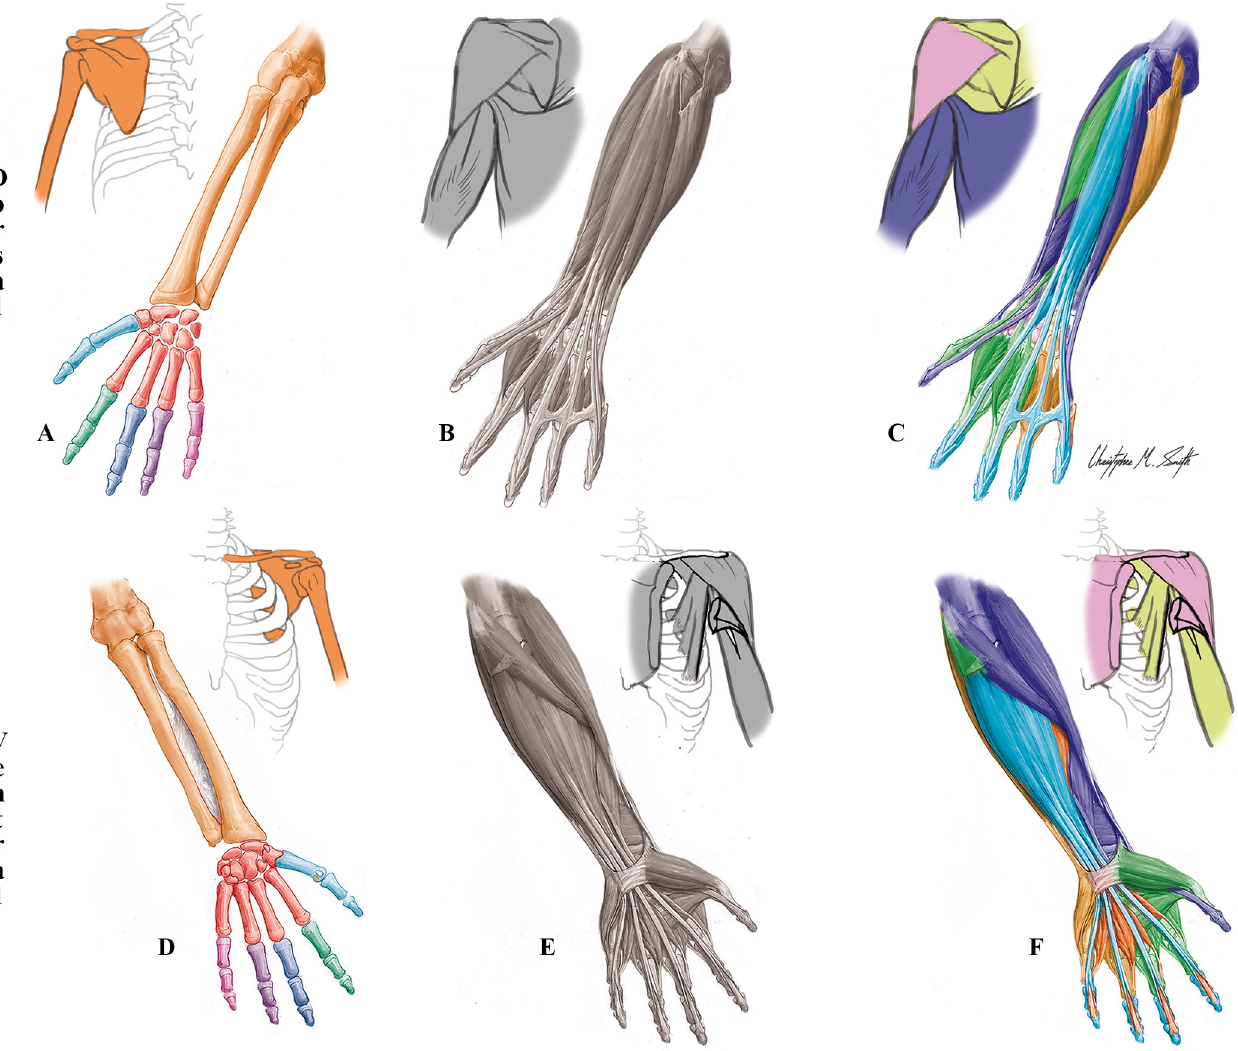
Fig 2. Modules of the normal newborn/adult left UL identified using AnNA. A to C dorsal (extensor) view; D to F ventral (flexor) view. It should be noted that the skeletal, muscular and musculoskeletal networks and modules of this left normal newborn UL are similar to the right one, and to both the left and right normal adult ULs). A, D) Skeletal network modules: in red , the wrist/metacarpals 2 – 5 module; in turquoise , the digit 1/metacarpal 1 module; in dark green , the digit 2 module; in dark blue , the digit 3 module; in purple , the digit 4 module; in pink , the digit 5 module; in orange , the girdle/arm/forearm module; in white , the radial sesamoid and ulnar sesamoid modules. B, E) Muscle network modules: no muscles create any modules in this network. C, F) Musculoskeletal network modules: in turquoise , the superficial flexor/extensor module; in purple , the arm-forearm-thumb movement module; in dark green , the digits 1-2-3 movement module; in orange , the profundus/lumbrical module; in yellow , the digits 4 – 5 movement module; in light green , the scapular module; and in pink , the clavicle movement module.